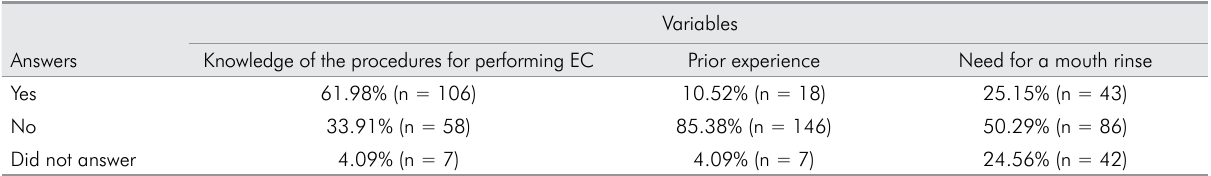
Table 2. Percentage of the sample (N = 171) regarding the following variables: knowledge of the procedures for performing EC, prior experience and the need for a mouth rinse before